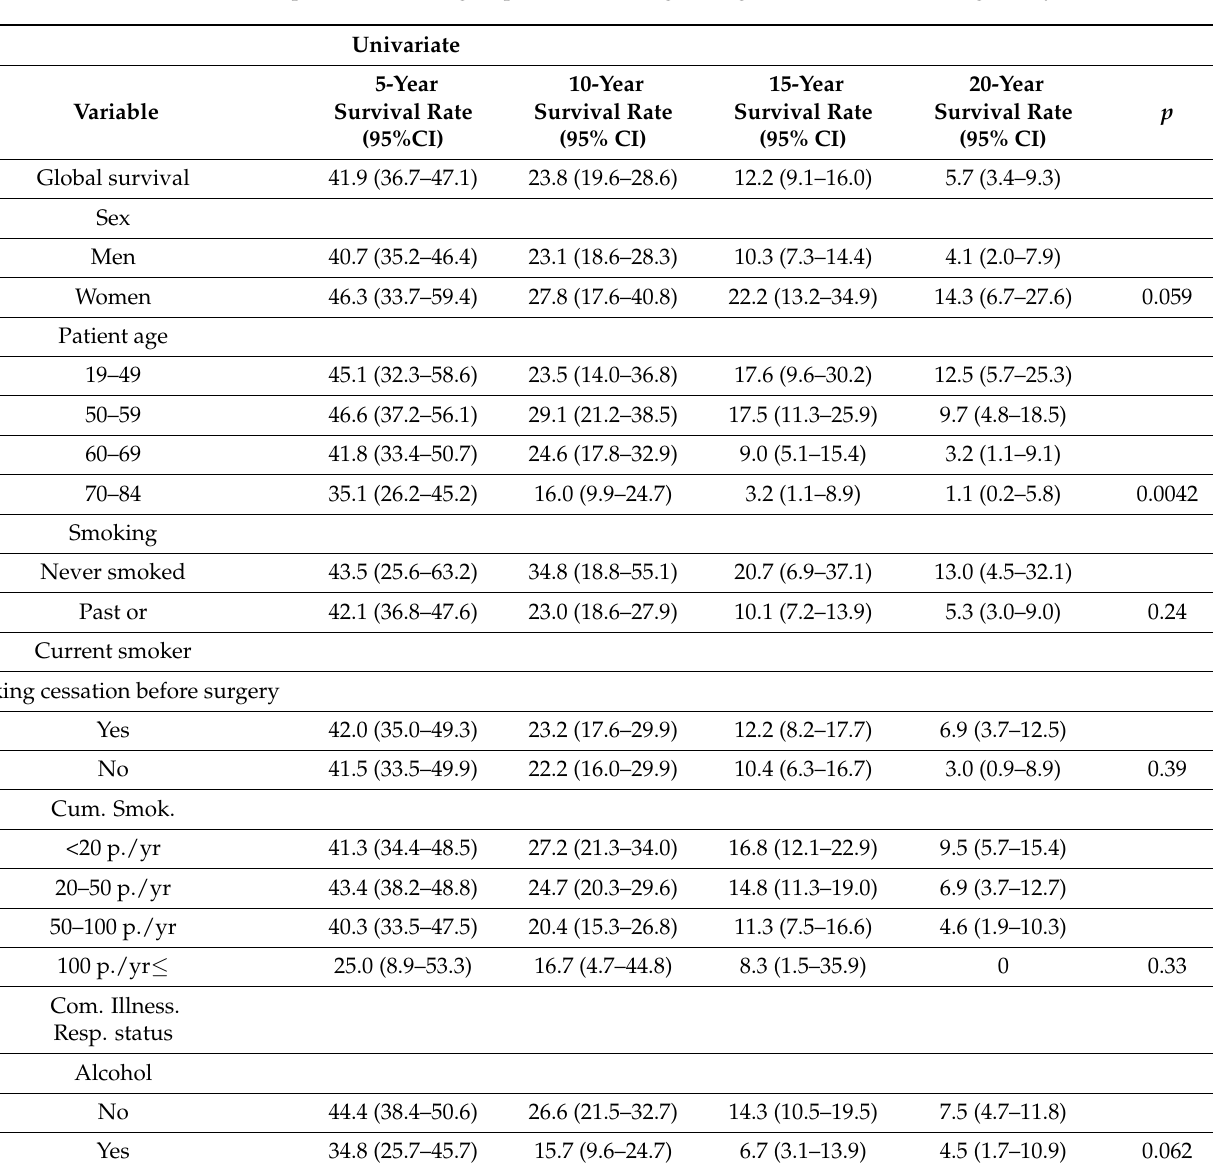
Table 2. Impact of clinical, pathological, and biological variables following univariate analysis on very long-term survival rates for the 345 study patients, obtained by Kaplan–Meier estimator, and comparison for each group of factors using the log-rank method censoring at 20